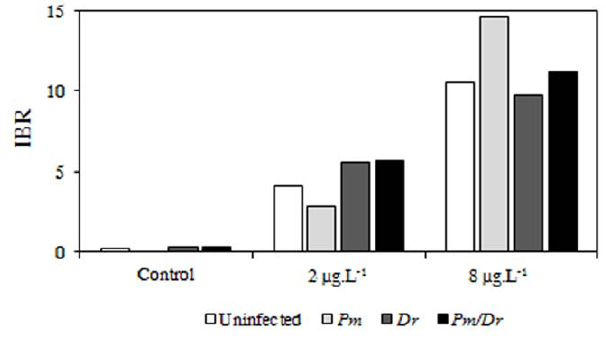
Figure 2. Integrated Biomarker Responses measured in G. roeseli exposed to 2 and 8 m g Cd/L for 96 hrs. Pm: P. minutus - infected females, Dr: D. roeselum -infected females, Pm/Dr: co-infected females. IBR values include defence responses (GSH, GCL, MT, carotenoids) and MDA responses.